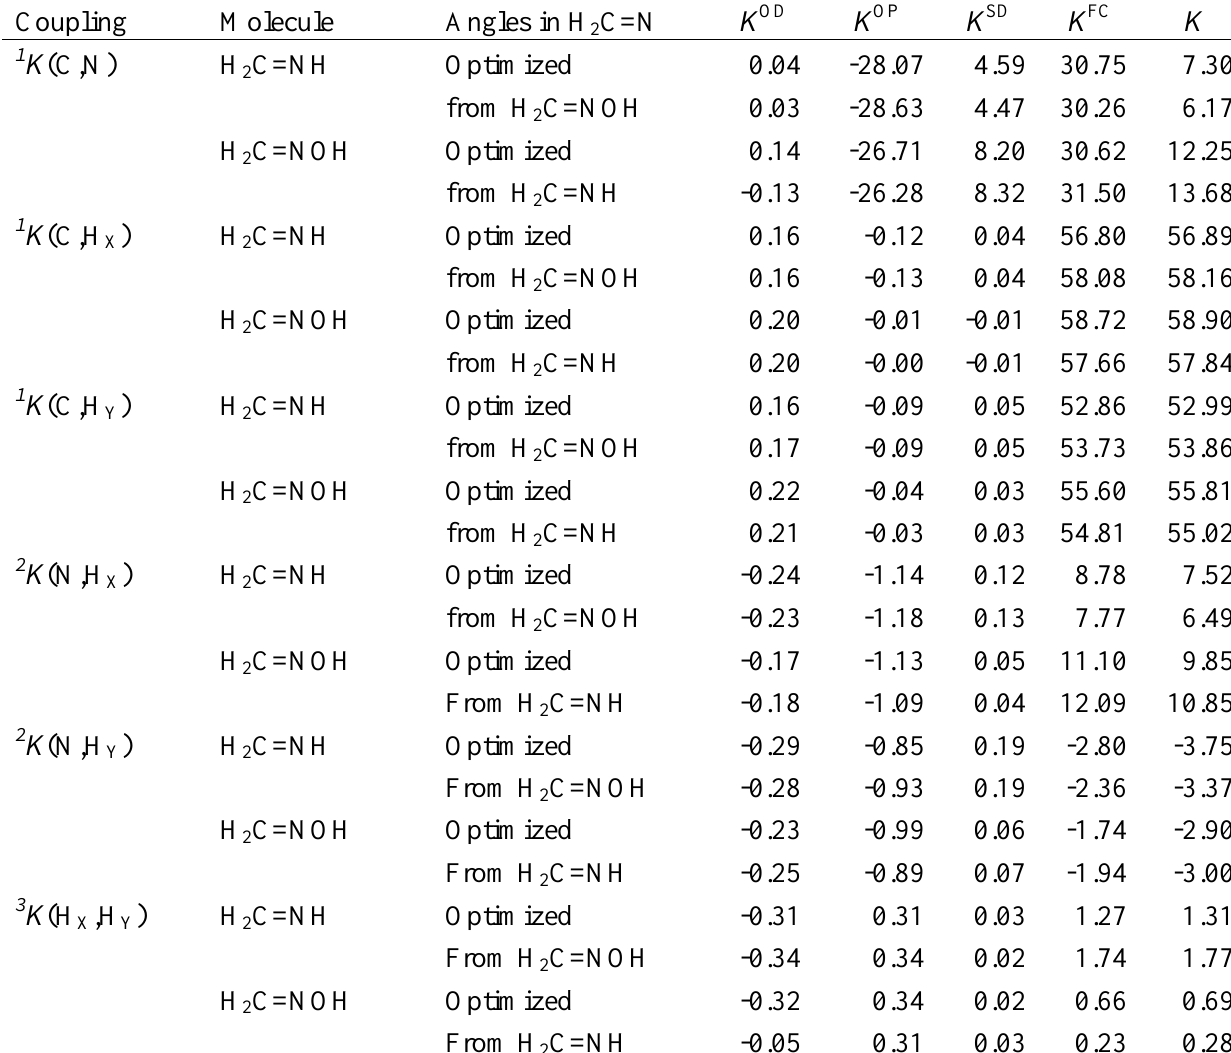
Table 2. Angle dependence of the reduced spin-spin couplings, K , (in 10 19 T 2 J -1 ) in H H C=NOH calculated at SOPPA(CCSD) 2